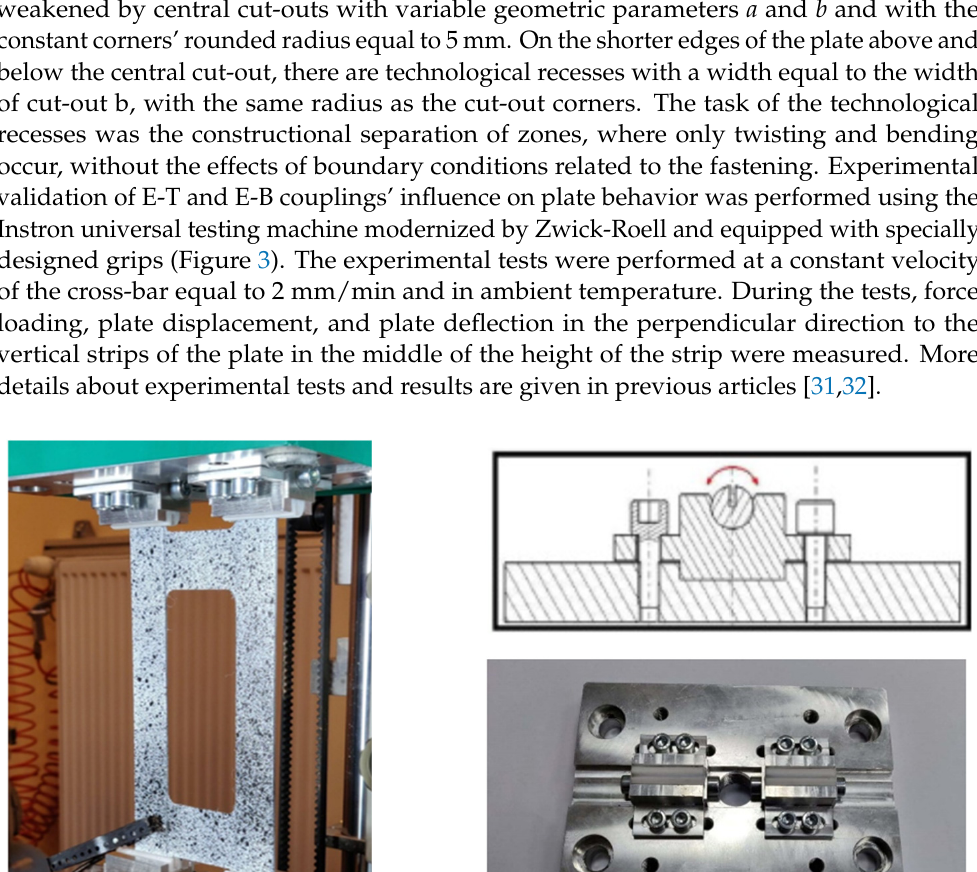
Figure 2. Manufactured process—vacuum package.